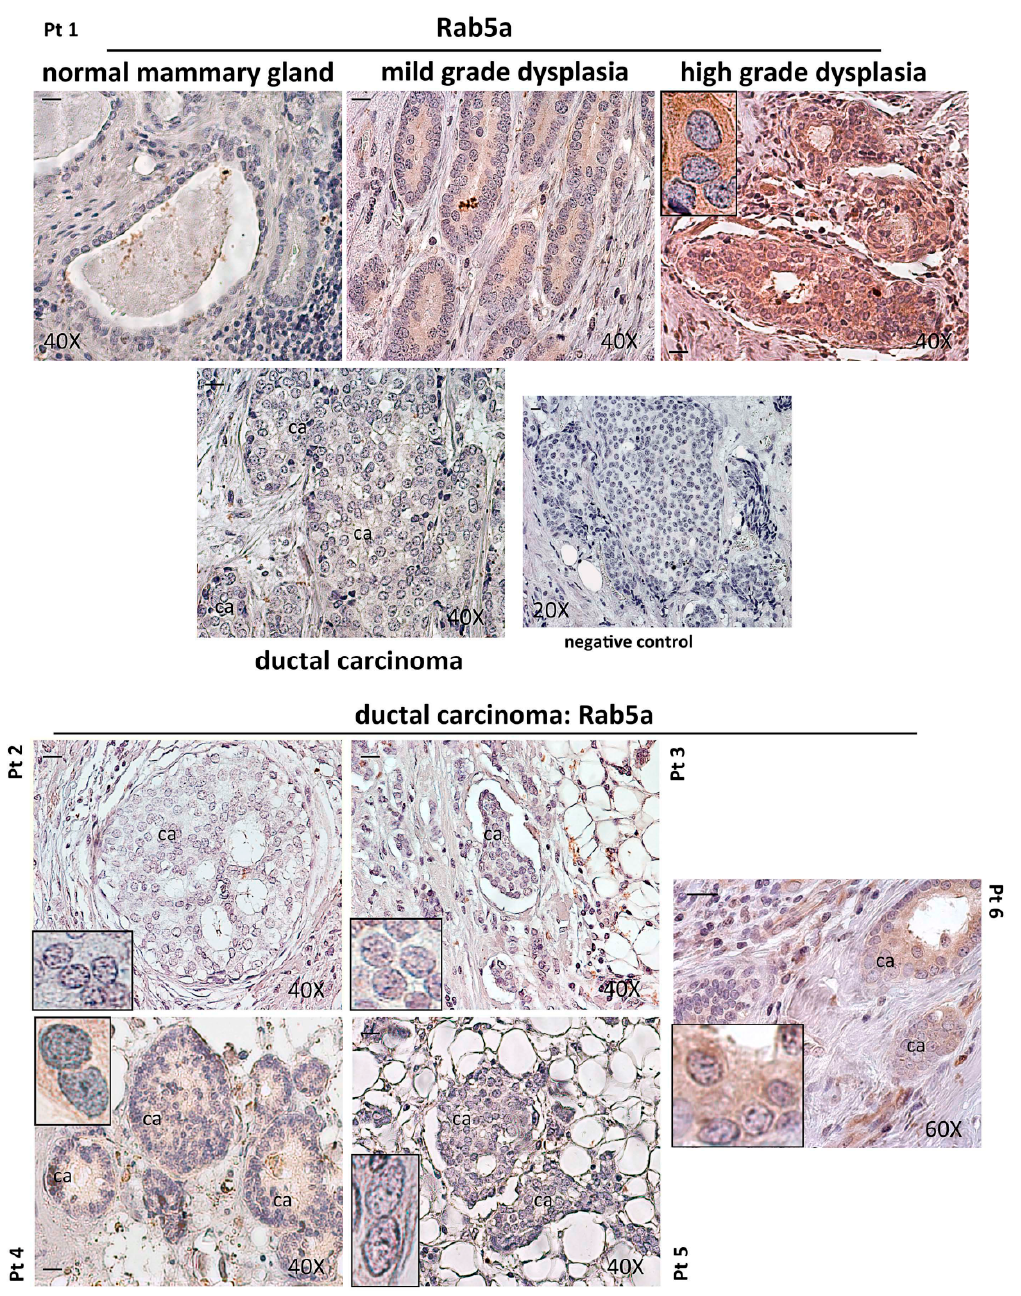
Figure 1. Rab5a expression in human dysplastic lesions and in invasive ductal breast carcinoma. Representative images of immunohistochemical staining for Rab5a were shown. The upper panels reported Rab5a signals for Patient 1 (Pt 1) throughout all the progression stages from normal mammary gland to mild and high grade dysplasia, and invasive ductal breast carcinoma. The lower panels reported the Rab5a signals for Pt 2–6 in invasive ductal breast carcinoma. Magnification of details is shown. Bar = 240 µm. Negative control was assayed without the specific antibody. We analysed by immunohistochemistry five serial sections prepared from each human specimen; ca, breast carcinoma.